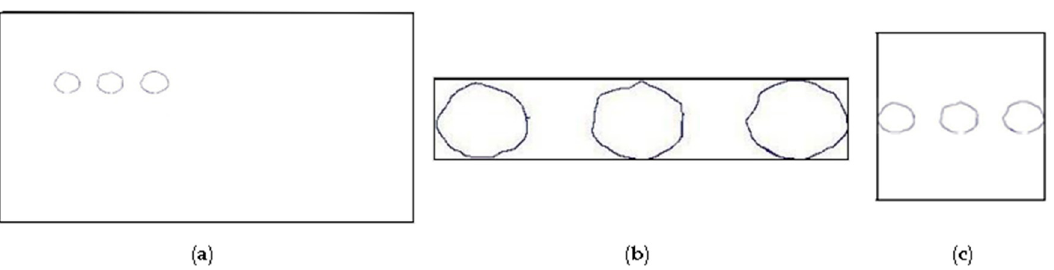
Figure 5. This figure explaining the automatic preprocessing of the input image as follows: ( a ) Original input image; ( b ) Cropped image; ( c ) Adjusted image.